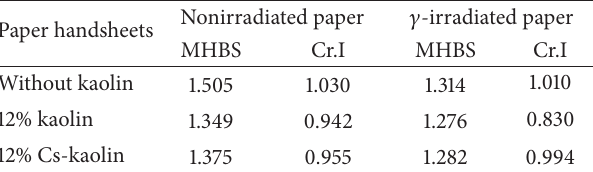
Table 3: Mean hydrogen bonds strength (MHBS) and crystallinity index (Cr.I) for wood paper handsheets before and after 𝛾 - irradiation.